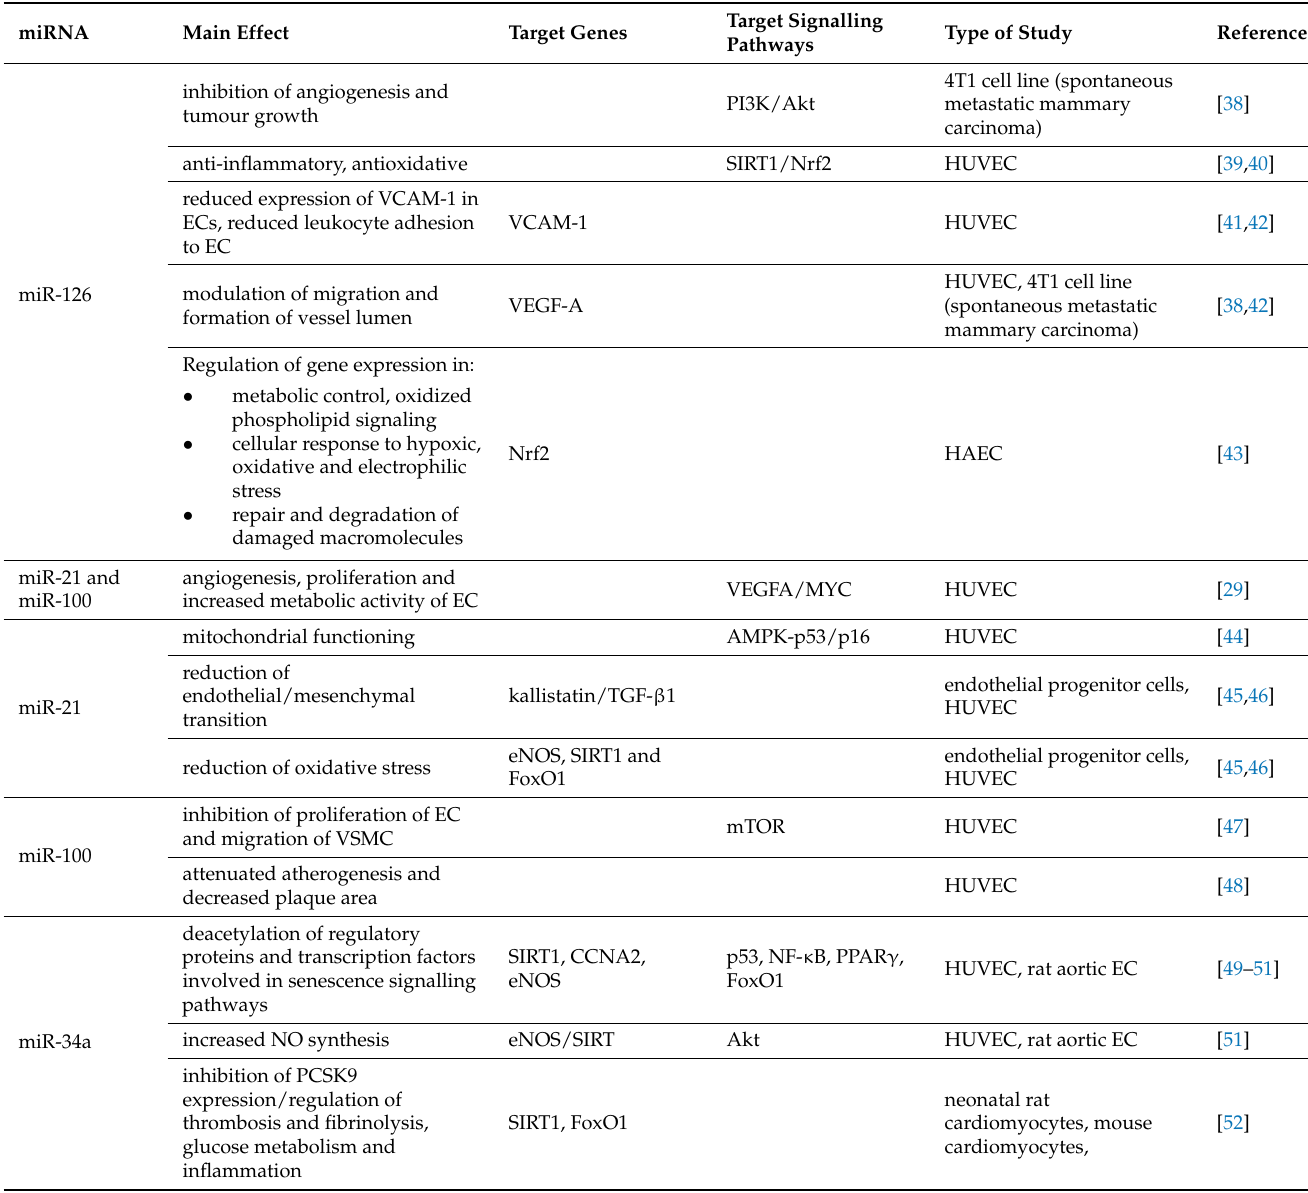
Table 1. Potential mechanism by which particular miRNA could take part in senescence pathophysi- ology and its target genes/signalling pathways by which the effect is achieved. HUVEC—primary human umbilical vein endothelial cells; HAVEC—primary human aortic valve endothelial